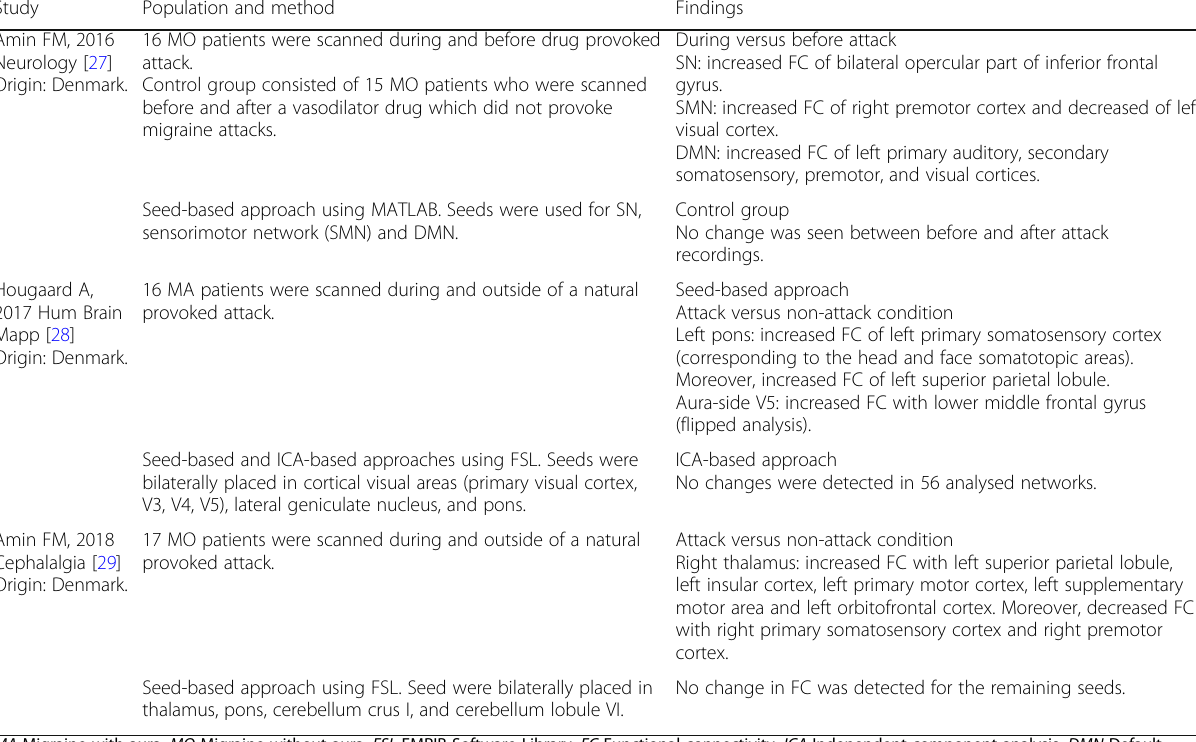
Table 2 Functional connectivity MRI during and outside of the ictal phase of migraine Study Population and method